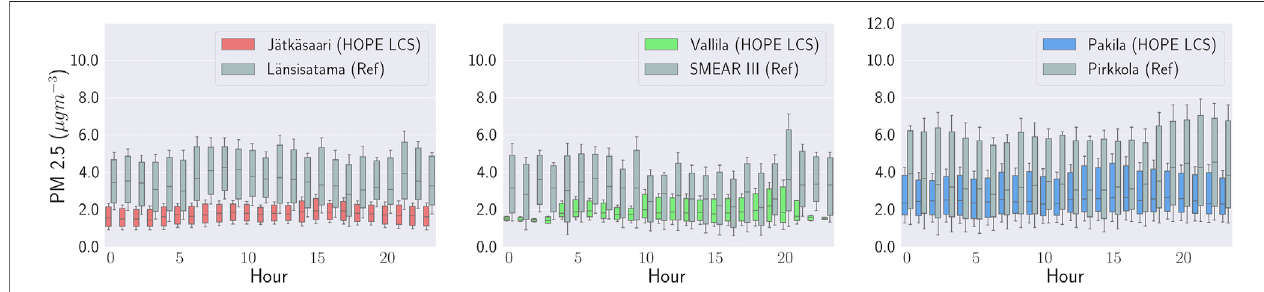
FIGURE4| Hourly PM 2.5 concentrationsfromHOPEsensorsincomparison withthatmeasuredatreferencestationsinthedistrictsof (A) Jätkäsaari(redbars), (B) Valilla (green bars) and (C) Pakila (blue bars), in the campaigns in 2020. The grey bars represent the hourly PM 2.5 concentrations at the corresponding nearest reference stations.